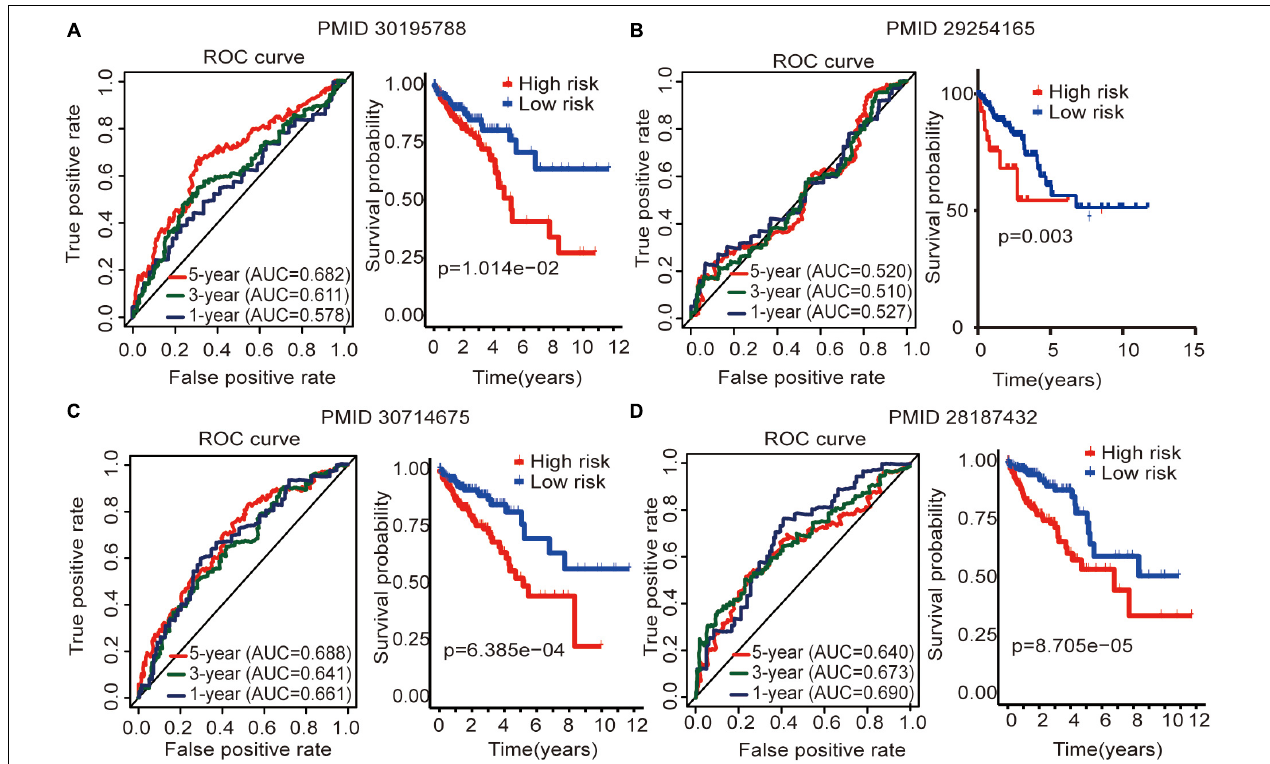
FIGURE 6 | Four lncRNA signatures predict prognosis of colon cancer in the entire TCGA cohort. (A) Zhou et al. (2018) (PMID30195788) six-lncRNA signature in the entire TCGA cohort. (B) Xue et al. (2017) (PMID29254165) two-lncRNA signature in the entire TCGA cohort. (C) Zhang et al. (2019) (PMID30714675) five-lncRNA signature in the entire TCGA cohort. (D) Zeng et al. (2017) (PMID28187434) four-lncRNA signature in the entire TCGA cohort. The AUC value of the ROC curve is used to evaluate the ability to predict, and the survival curve is used to analyze the difference in prognosis between the high and low expression groups.